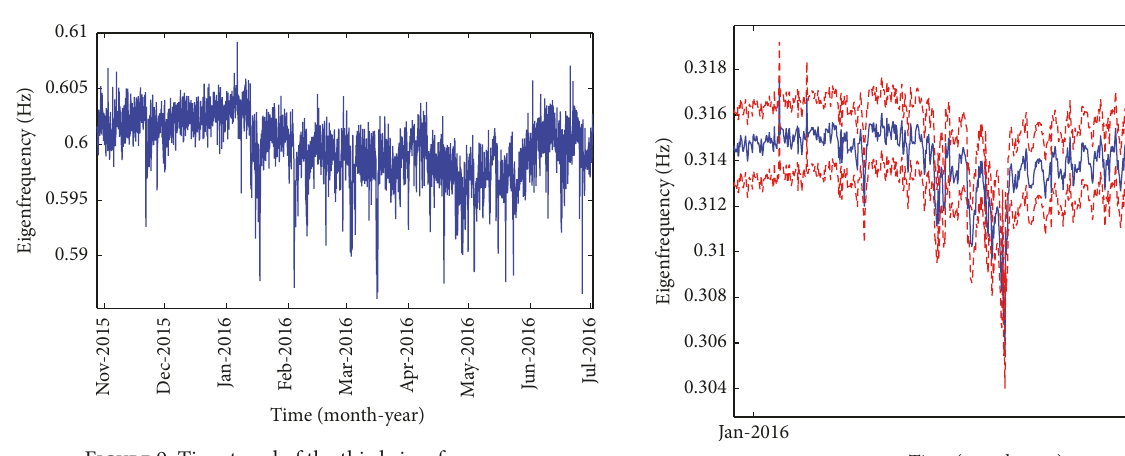
selected two quantities: the acceleration RMS and the value of the building inclination. Many correlation studies